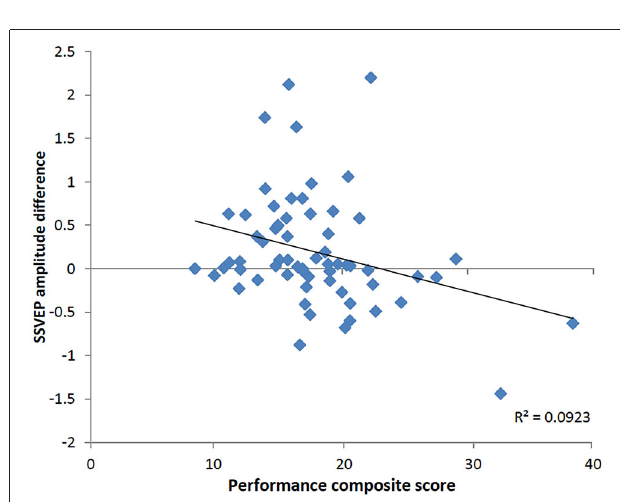
FIGURE 6 | Scatterplot displaying relationship between SSVEP amplitude reductions and the working memory performance score at right prefrontal electrode FP2 in the older group (Pearson’s r = − 0.30, p < 0.05) . Timing corresponds to the encoding time point shown in the correlation map in Figure 5. Positive values indicate larger SSVEP amplitude reductions for the working memory task relative to the control task and larger performance score is indicative of poorer task